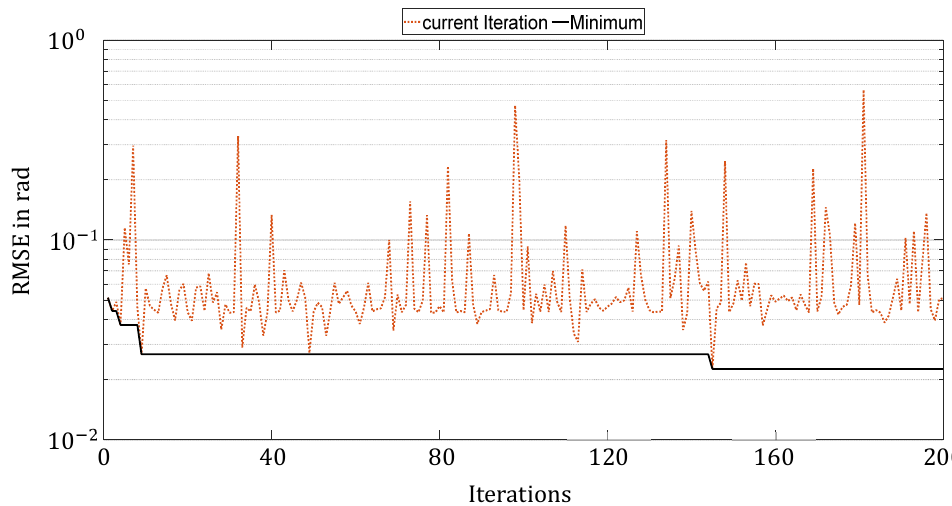
Figure 7. Progress of hyperparameter optimization with Random Search over 200 iterations.